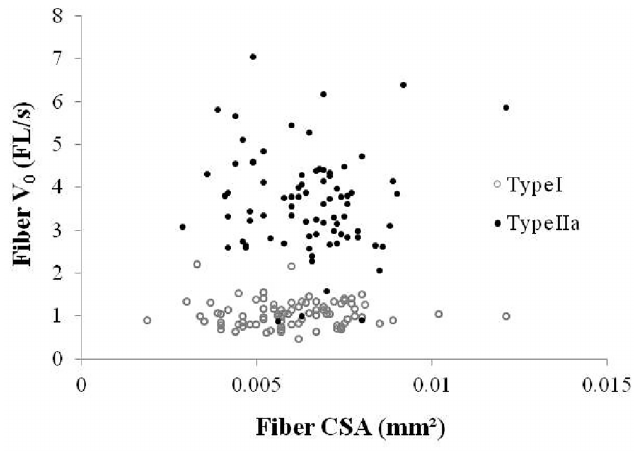
Fig 2. Correlation between V 0 (FL/s) and fiber CSA of type I (A) and type II a fibers